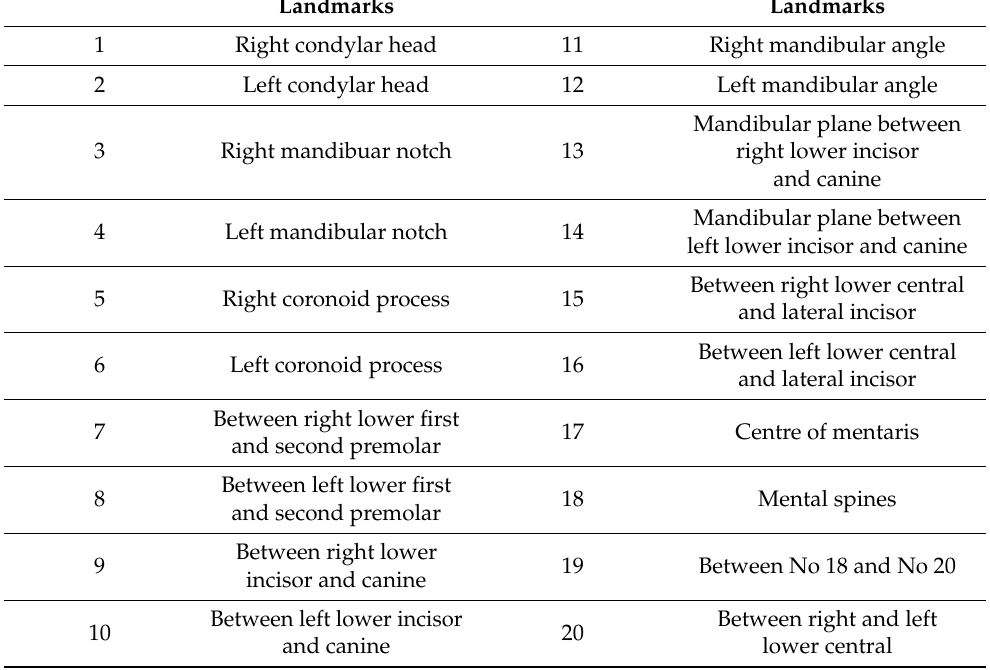
Table 1. The anatomical landmarks in total mandible.